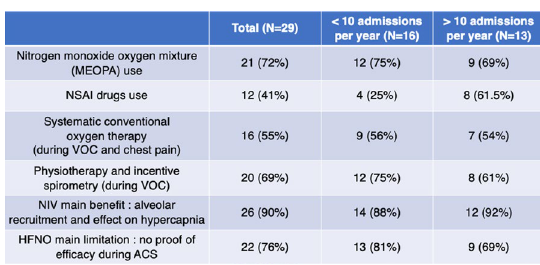
Table 1: main management and respiratory devices effects according to the number of patients with sickle cell disease admitted per year. FC‑088 Acute exacerbations in chronic obstructive pulmonary